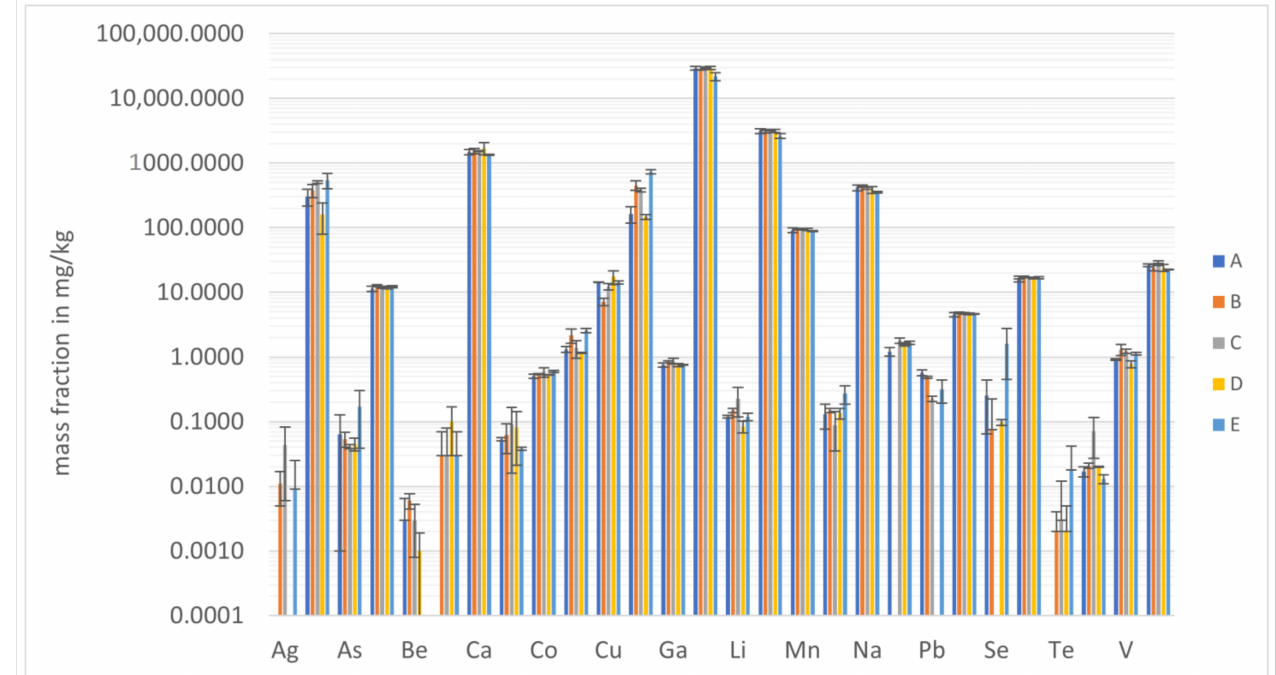
Figure 1. Mass fraction of all analytes in mg/kg obtained for sample K1 after digestions A–E. Error bars refer to ±